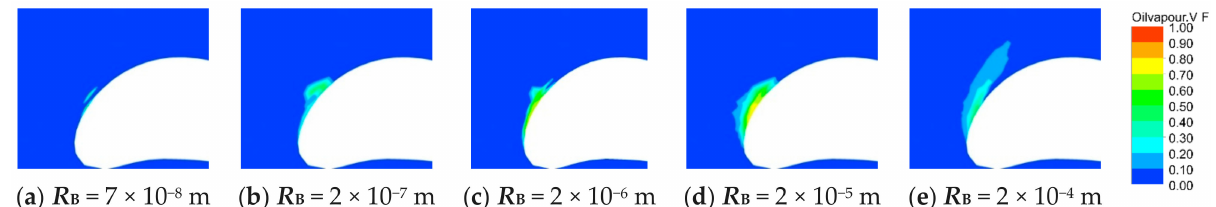
Figure 30. The oilvapor volume fraction distribution in stator domain at stall under various mean radius.